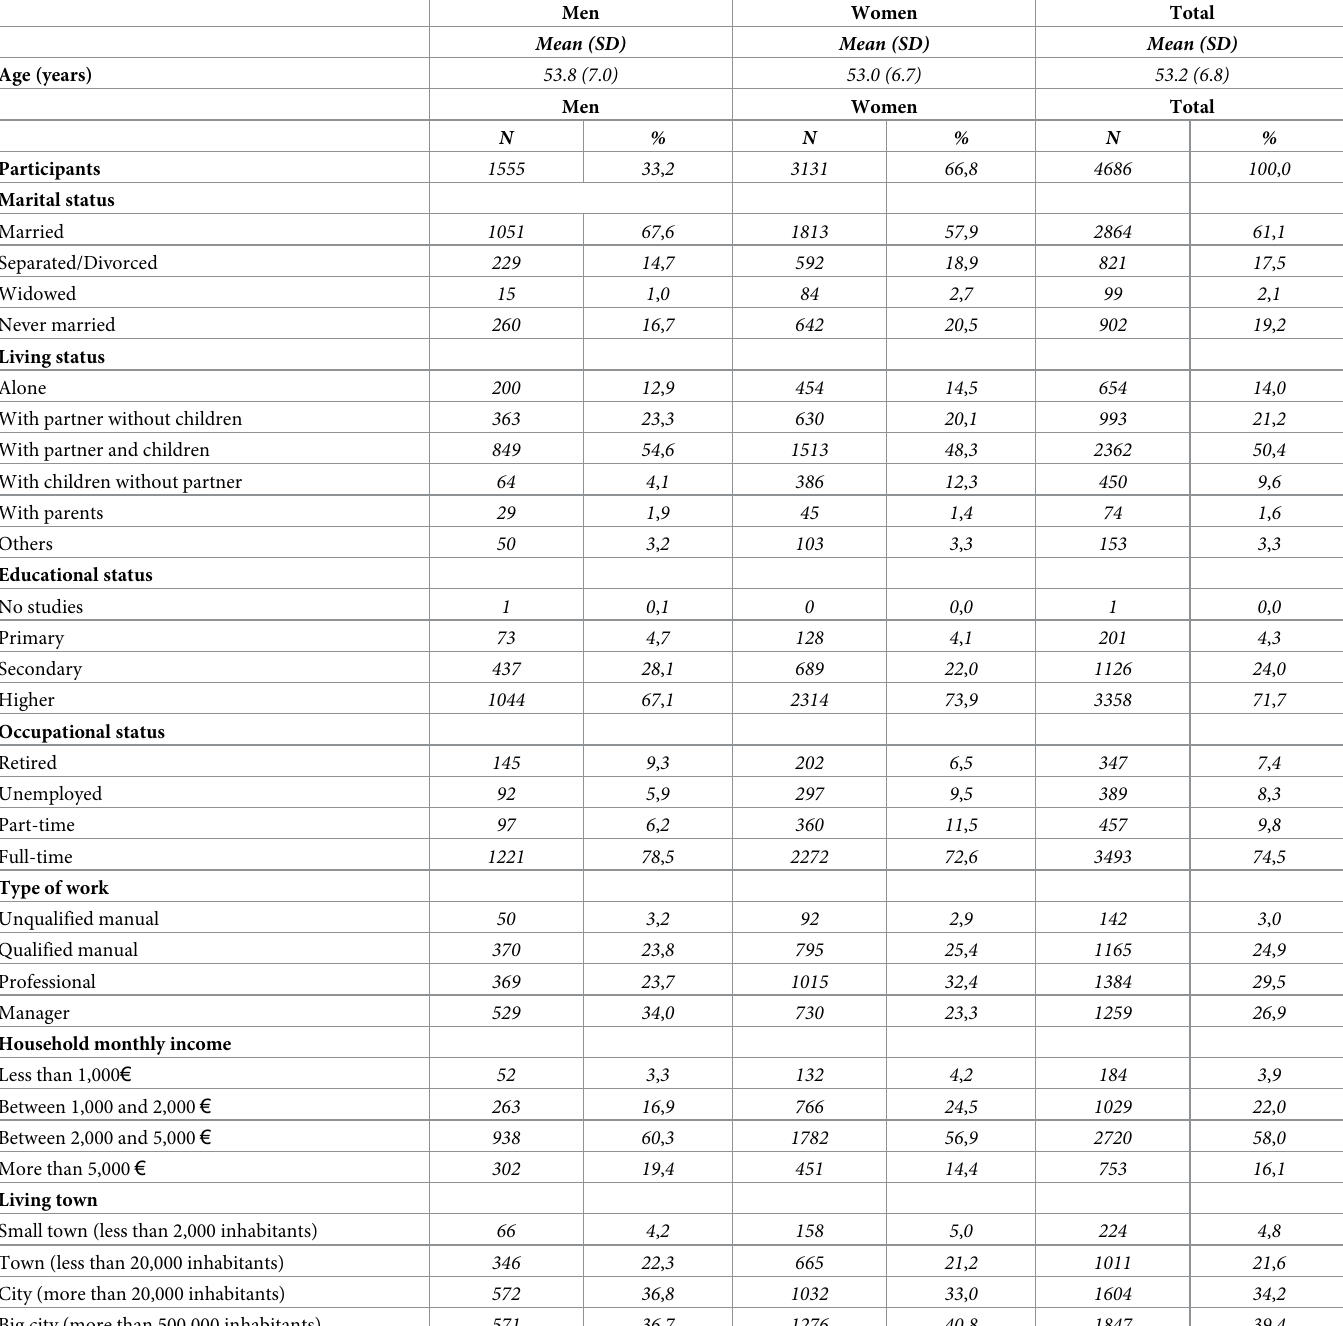
Table 4. Socio demographic characteristics of participants broken for biological